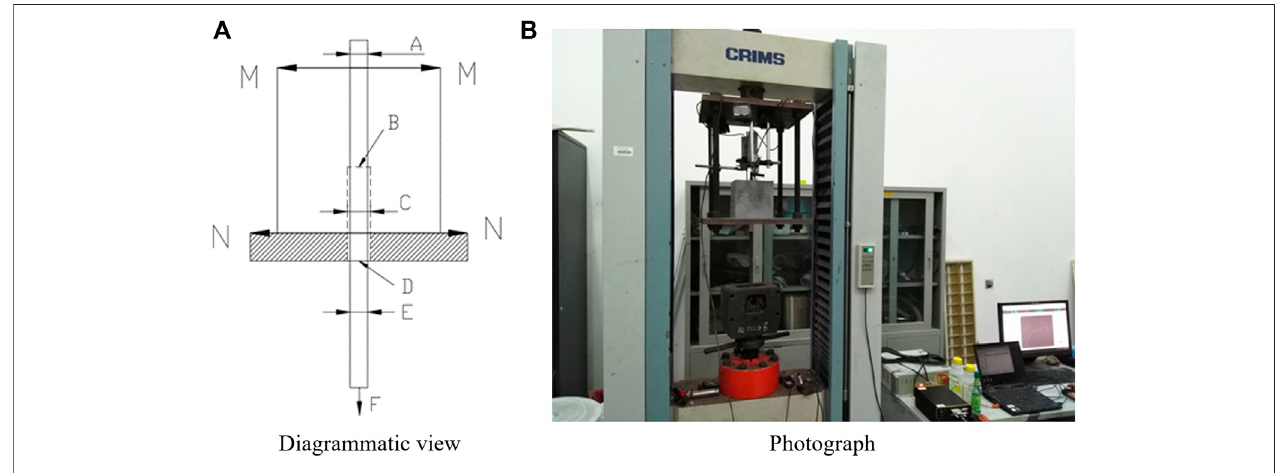
FIGURE 5 | Sketches of loading equipment and measurement